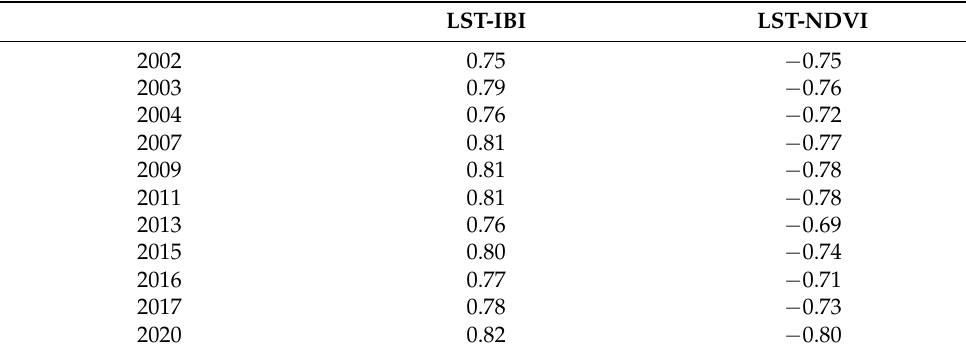
Table 6. Correlation coefficient values for LST–IBI and LST–NDVI